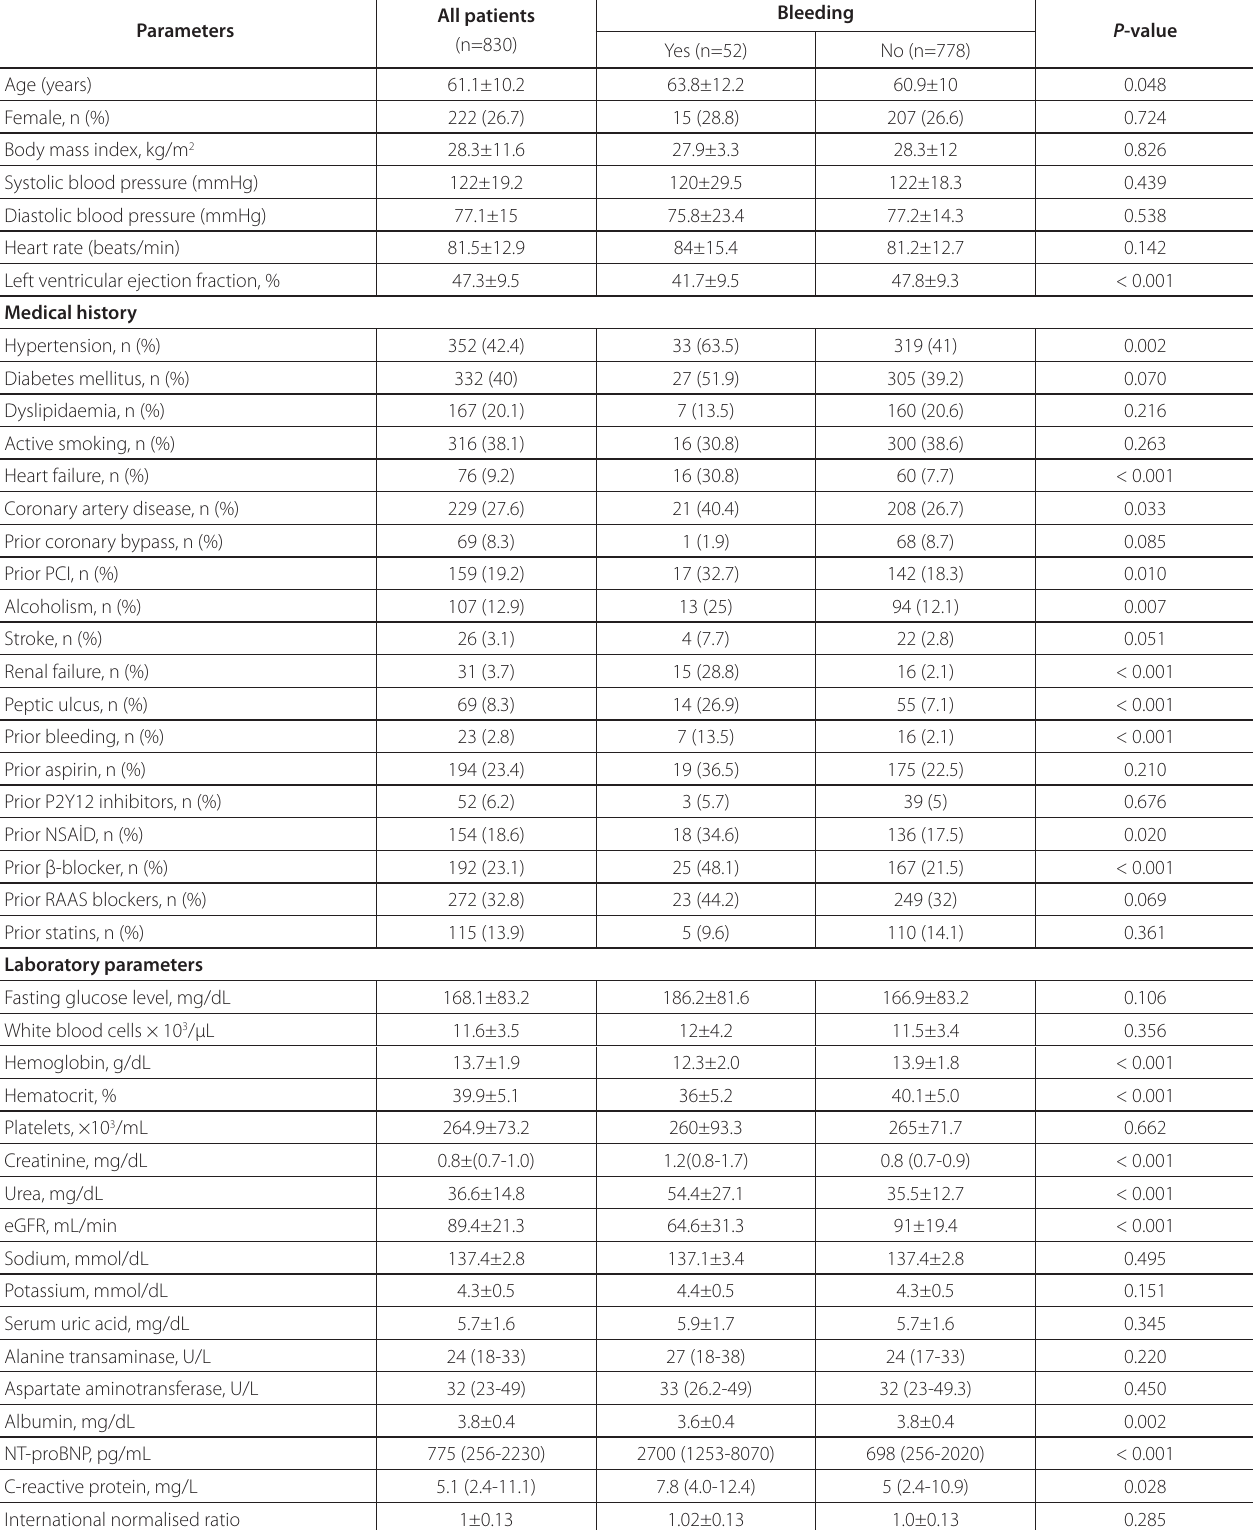
Table 1 . Baseline demographics, clinical characteristics, and laboratory parameters of the study sample.